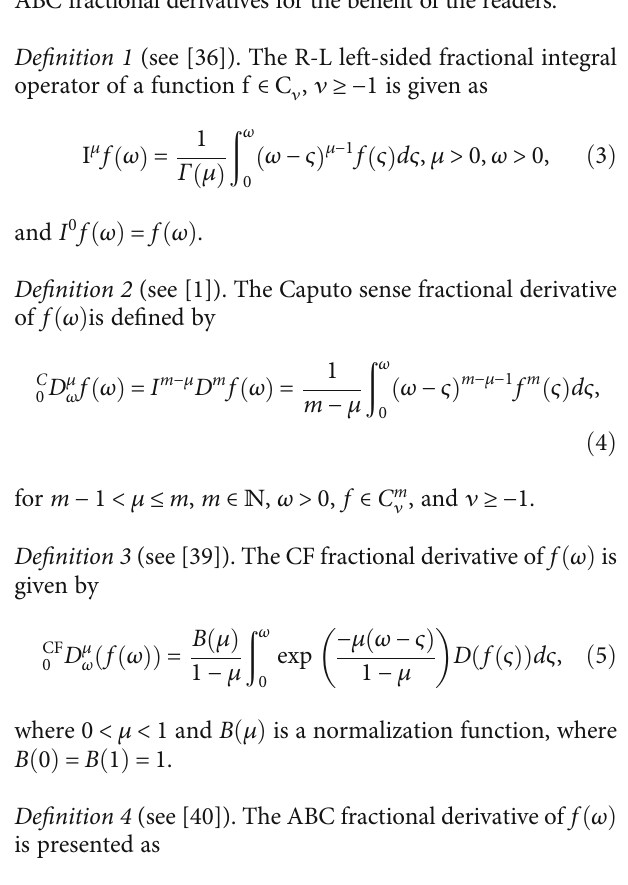
Table 1: Absolute errors of NTDM x ζ t NTDM